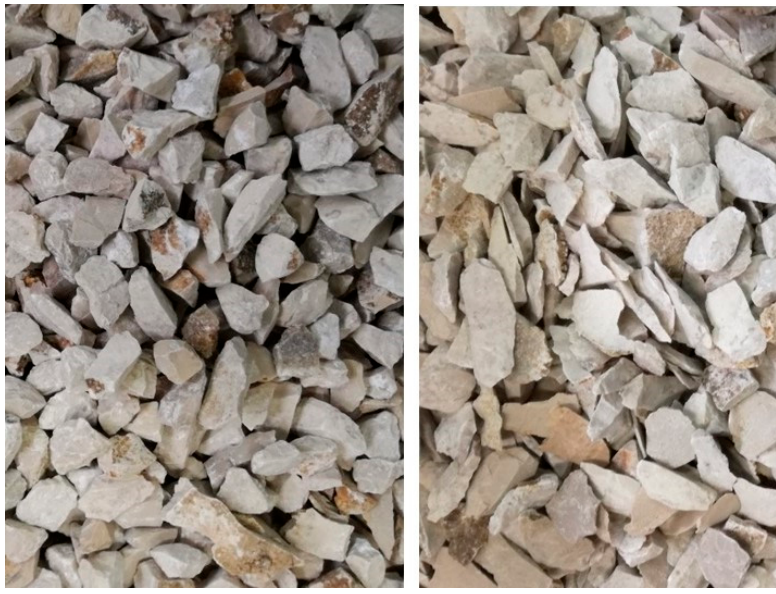
Figure 8. Final product: Limestone 8–16 mm regular ( left ), irregular ( right ).